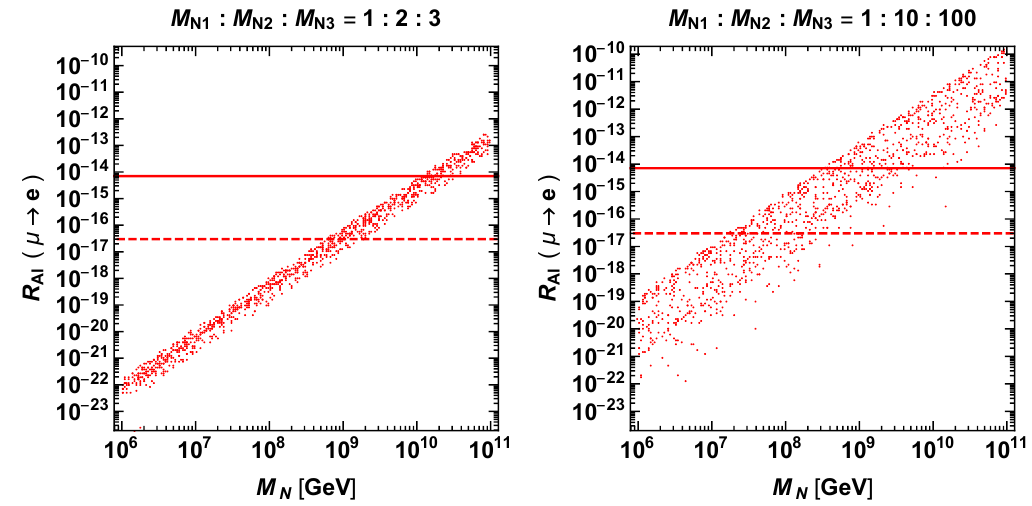
Figure 11 . BR( µ → eγ ) is shown for the model C . In the left (right) panel, M N 1 : 2 : 3 ( M N and M 2 = 2 TeV. The other parameters are taken as same as figure 10